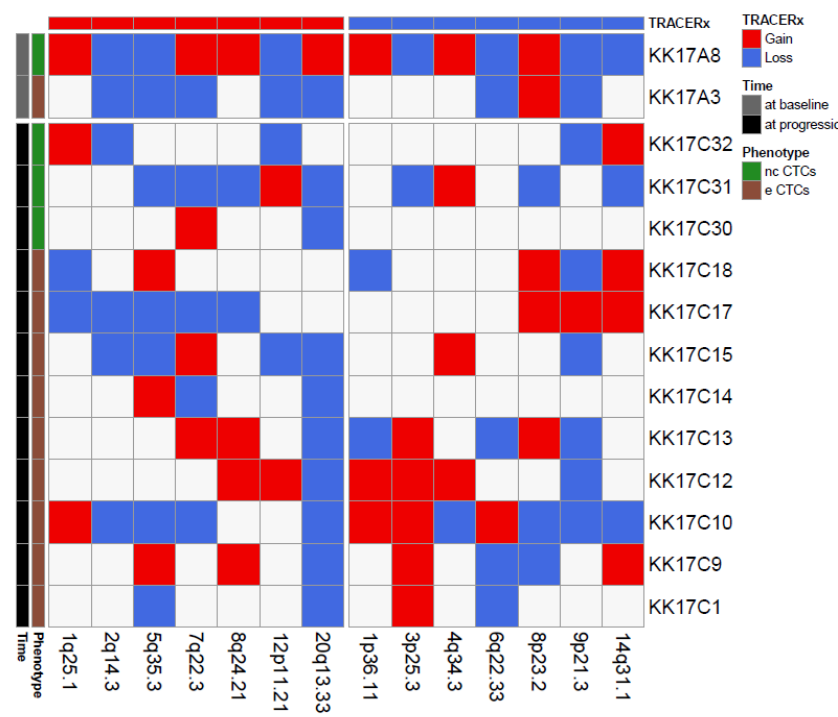
Figure 3. Matrix reporting genomic gains (red) and losses (blue) commonly observed in renal cell cancer for 14 CTCs isolated from patient K017. Color codes refer to blood collection timing and CTC phenotype.